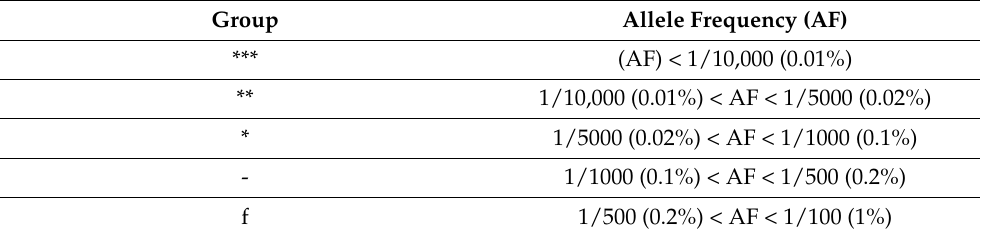
Table 2. Frequency subcategories of rare variants.